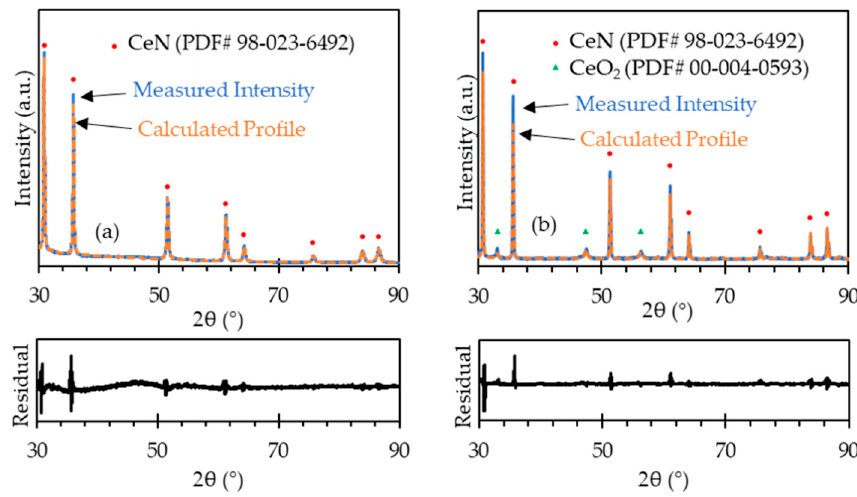
Figure 5. XRD patterns with profile fitting residual of ( a ) milled CeN powder and ( b ) the as-sintered